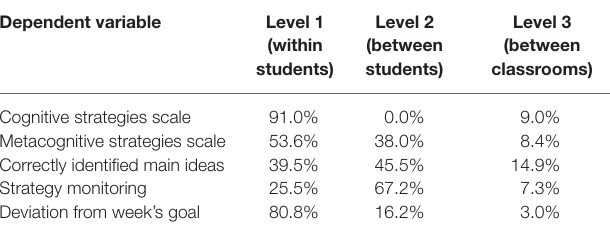
TABLE 3 | Variance decompositions for the unconditional random effects